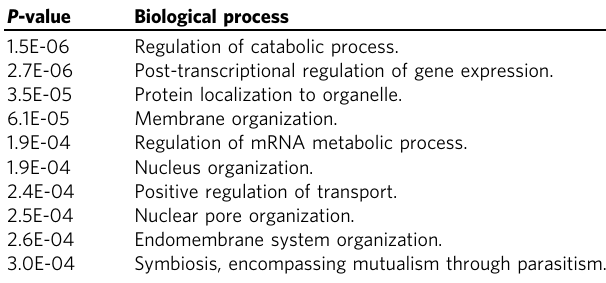
Table 1 Top biological processes enriched for genes that display 3 ʹ UTR shortening in TB differentiation from